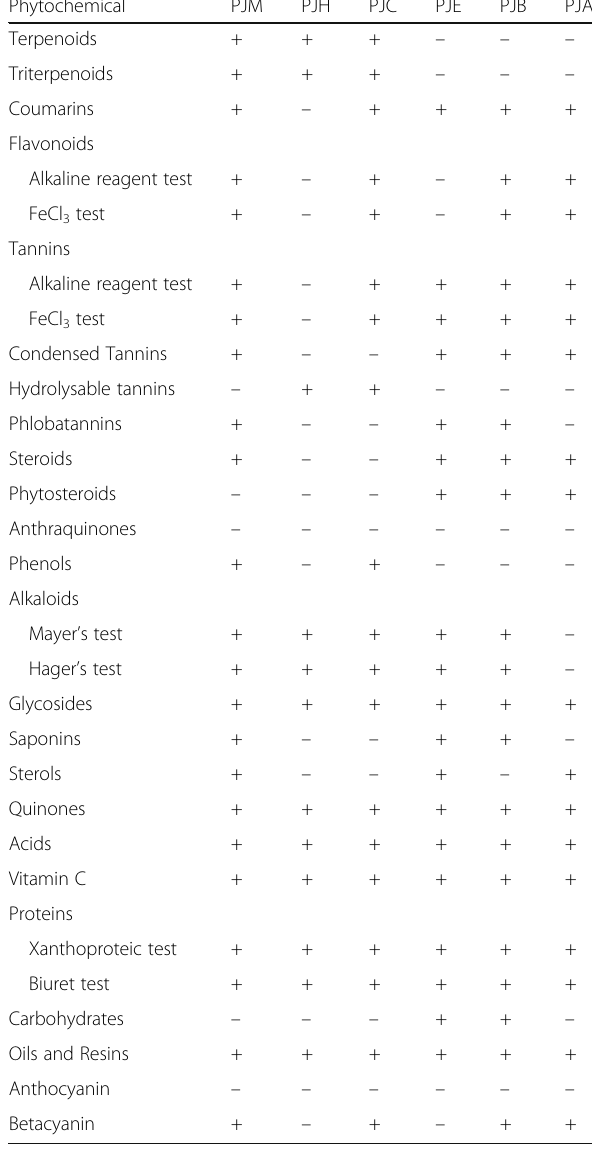
Table 1 Extraction yield of P. jacquemontiana methanol extract and its corresponding fractions Plant sample